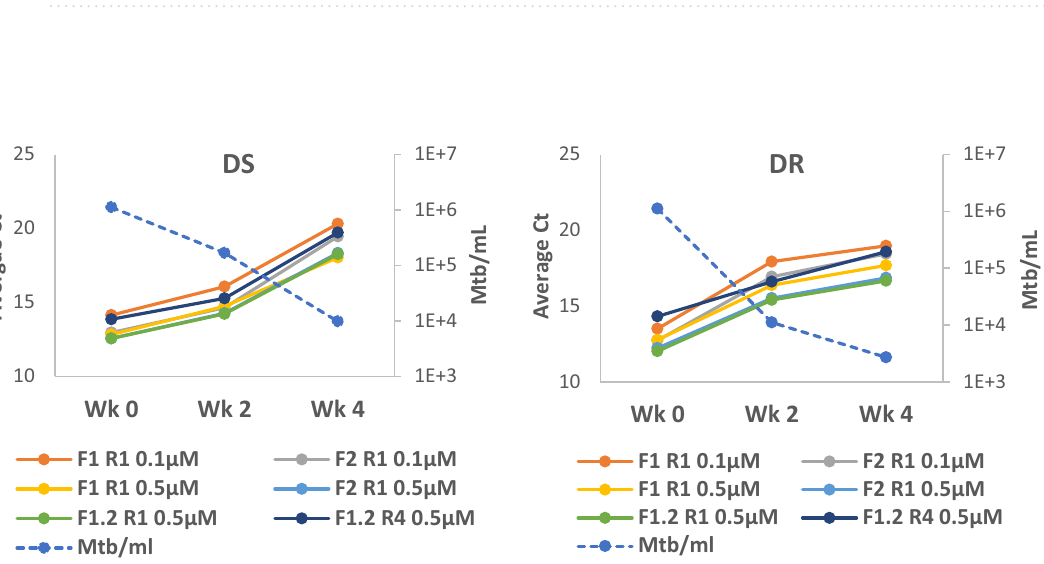
Figure 3. qRTPCR cycle threshold values for a representative 16S rRNA primer set (F1 R1 0.1 µM) show a strong correlation with M. tuberculosis (Mtb) numbers from patient sputum samples when analyzing all samples (both pre- and post-initiation of treatment) from both cohorts ( A ); or each cohort individually ( B ). This correlation decreases for subjects with drug sensitive TB (DS) after initiation of a rifampin-based combination therapy ( C ). Mtb numbers represent the highest Mtb/mL obtained by either CFU or limiting dilution assays with or without culture filtrate. Results for the other 16S rRNA primer sets are presented in Fig. S13.